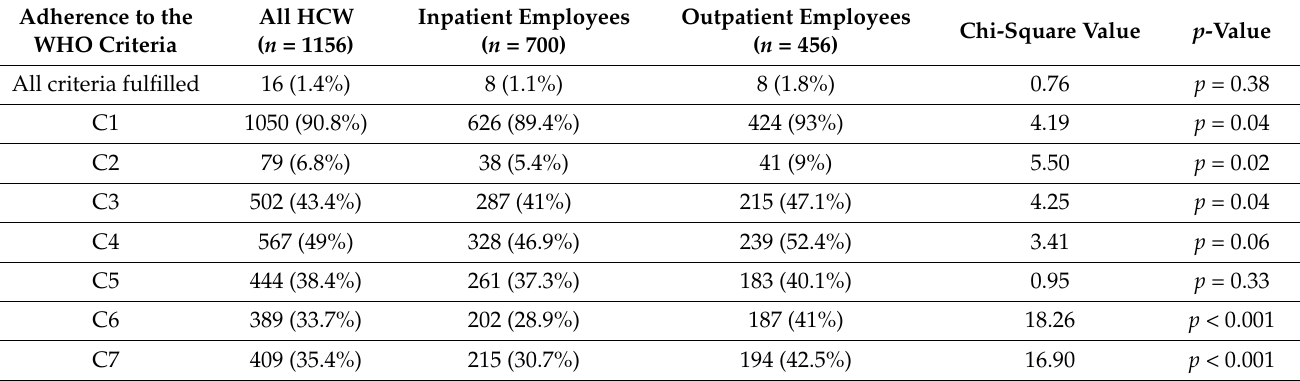
Table 3. Adherence to the WHO criteria among inpatient and outpatient